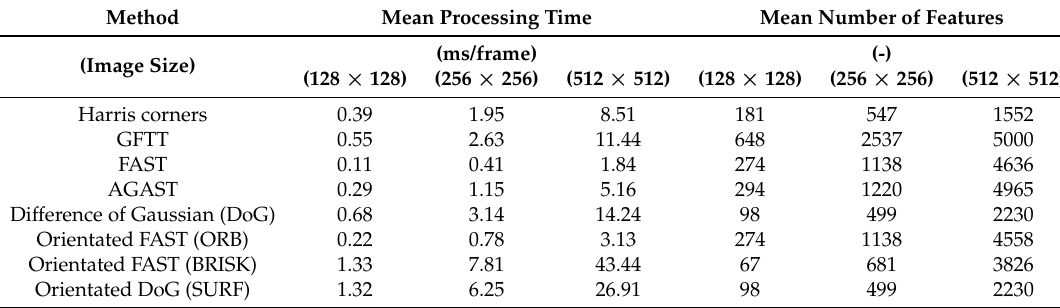
Table 5. Average processing time per frame on an Intel core i5-4590 CPU for various methods of feature detection together with mean number of features detected for different image